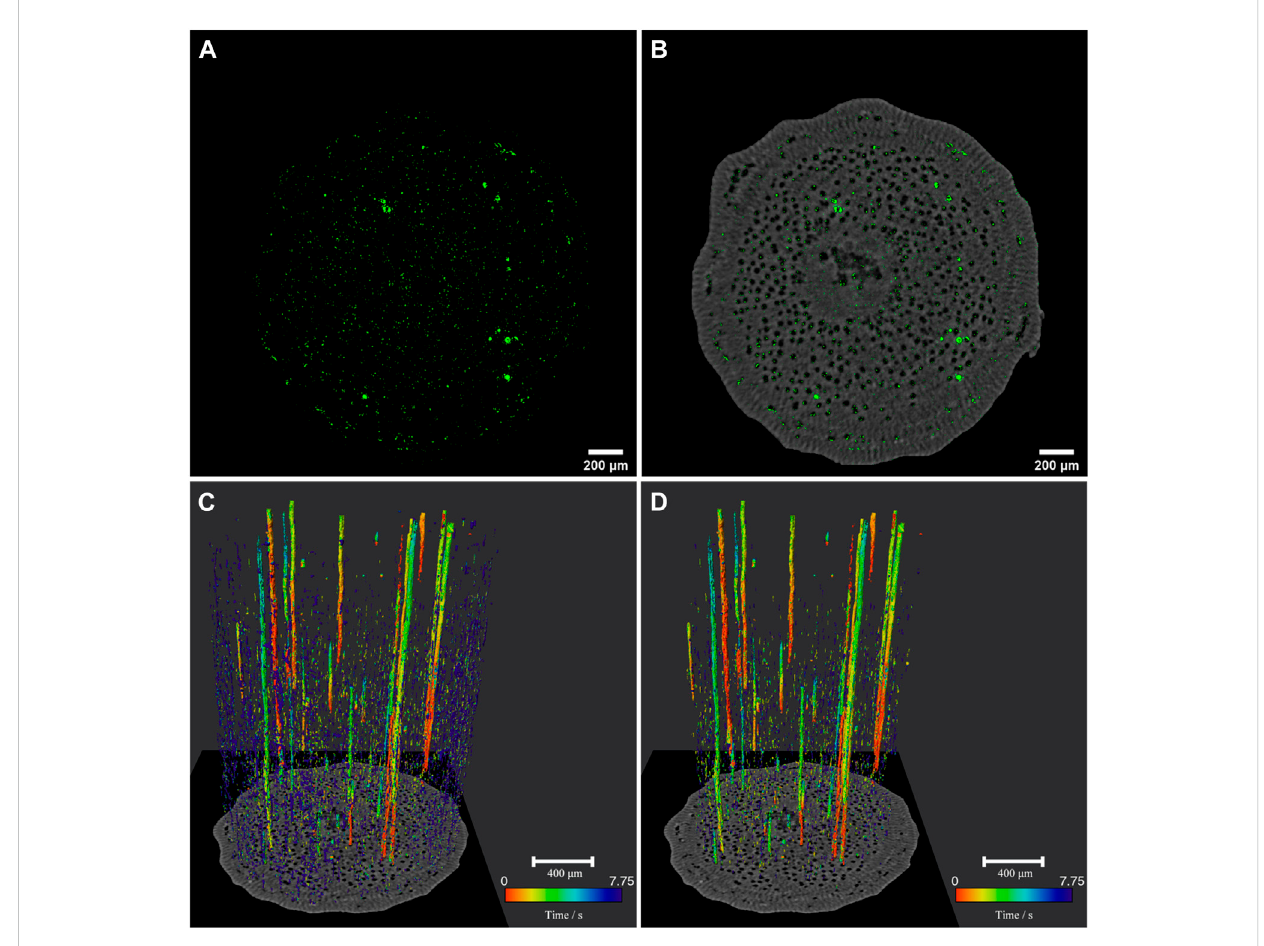
FIGURE 1 ImagingresultsforMCXCT. (A) MCXCTsliceNo.700at7.75 s. (B) FusionofCTslice(grayscale)andMCXCTslice(green)at7.75 s (C,D) Temporaland spatial distribution of re fi lling water in willow branch (C) and vessels (D) , with the color bar corresponding to time 0 – 7.75